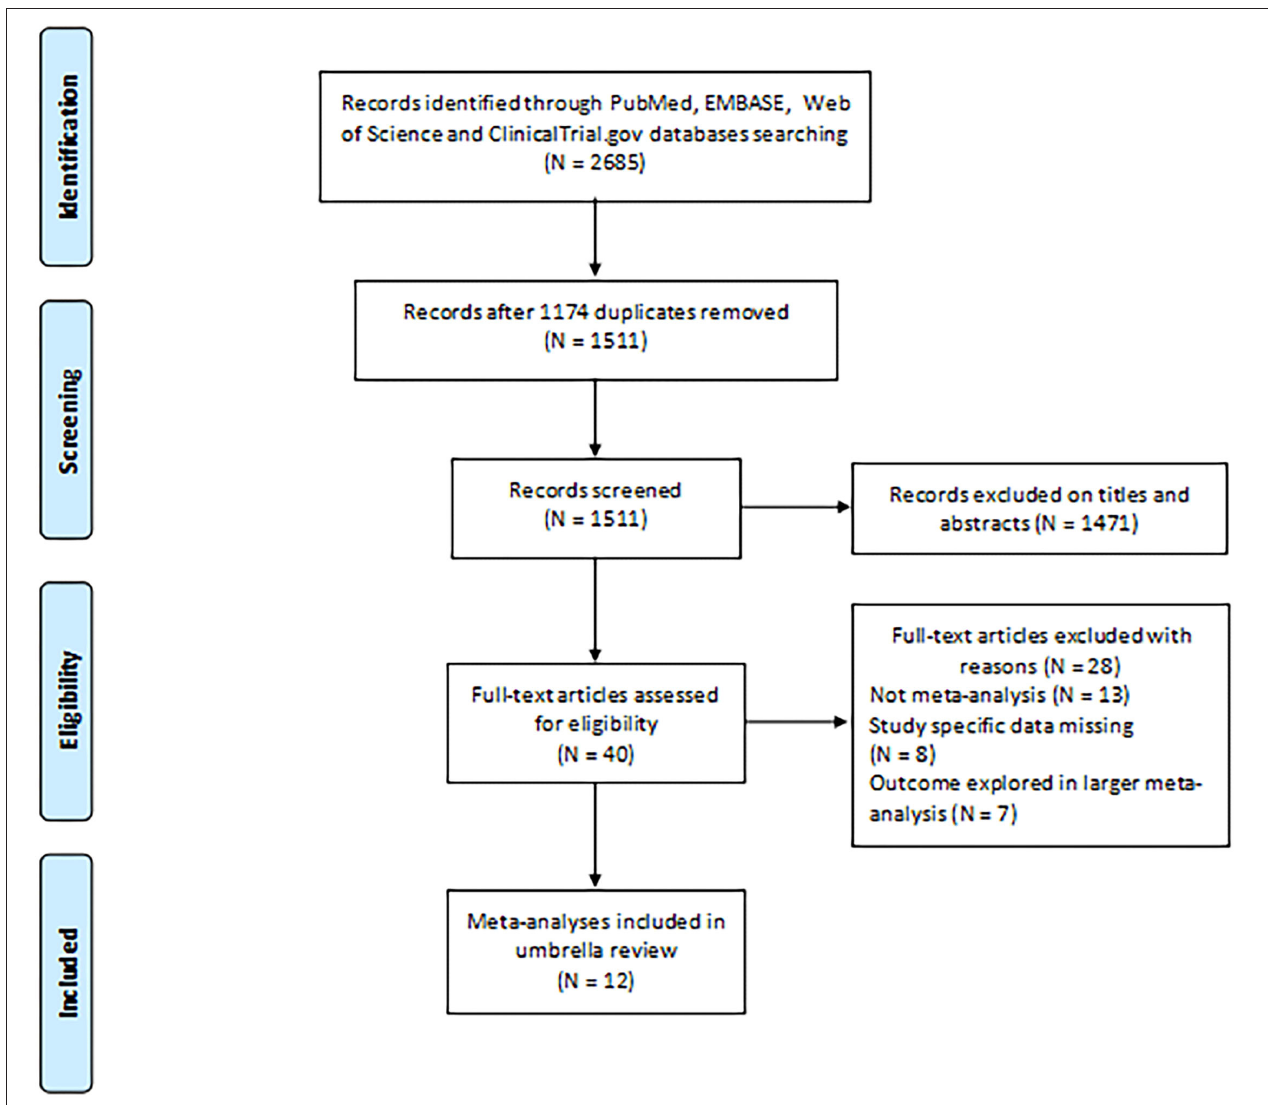
FIGURE 1 | Flowchart depicting the selection of studies for inclusion in our umbrella review relating to the potential association between environmental risk factors and endometriosis.